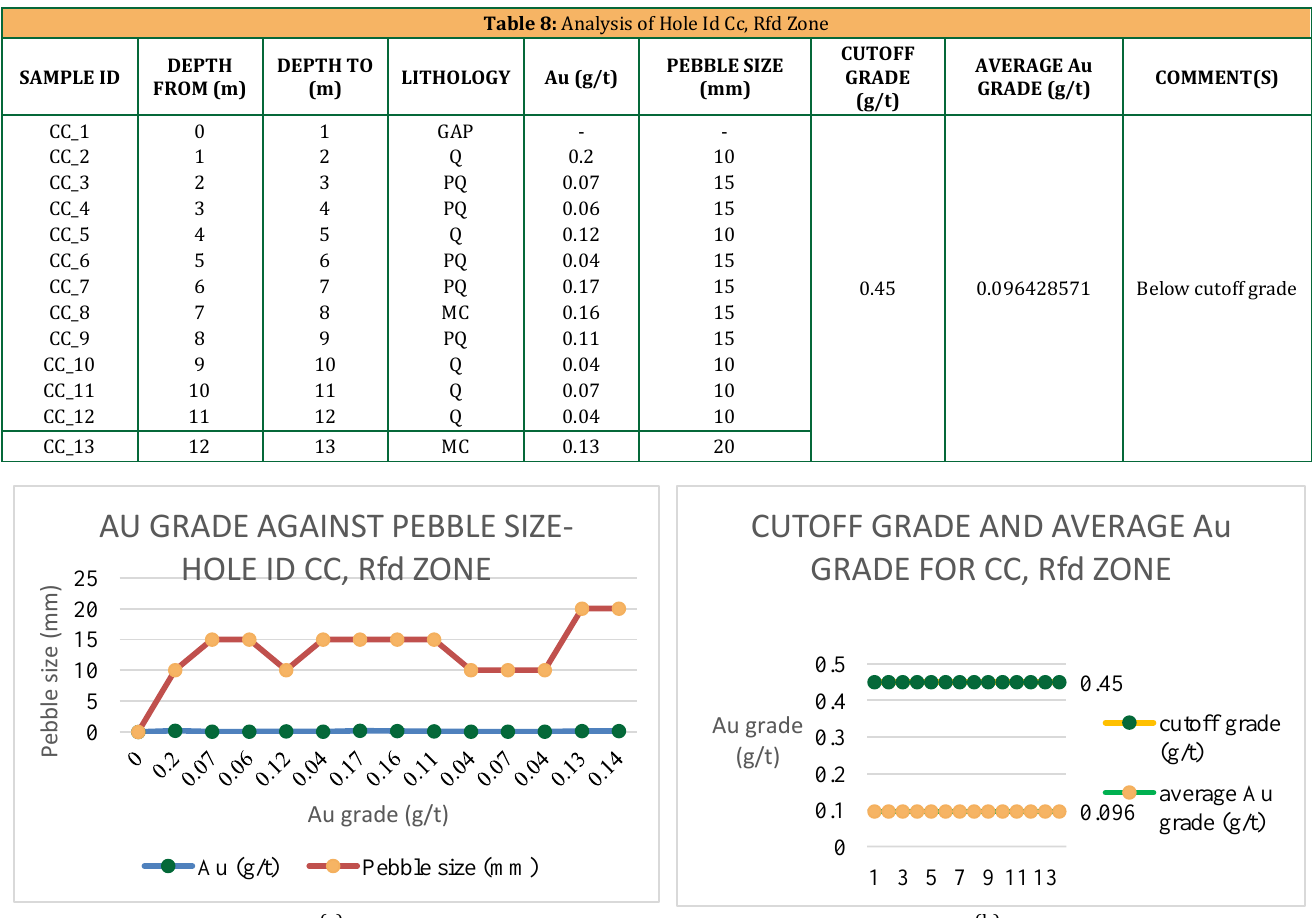
Figure 7: (a) Pebble size against Au grade -Hole ID CC, Rfd zone; (b) Cutoff grade and Au grade for CC, Rfd